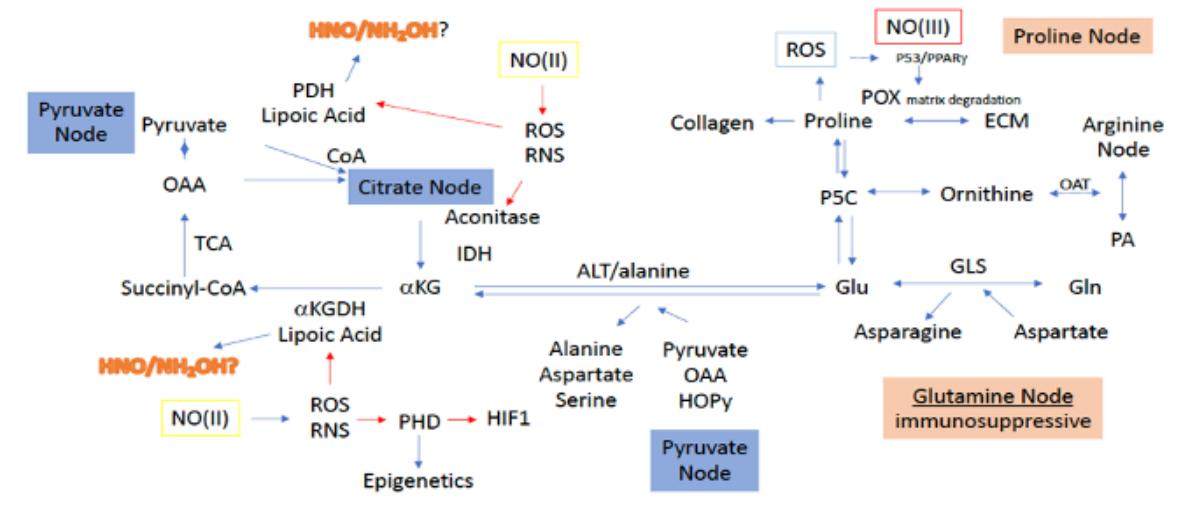
Figure 3. Sites for NO interaction with the a-KG node, as well as its associated amino acid paths. Green boxes/(II) represent intermediate levels of NO (nitrosative signaling) and red boxes/(III) indicate high levels of NO (nitrosative stress) required for NO interaction at the indicated site. Red arrows indicated inhibitory mechanisms while blue arrows indicate activating mechanisms.